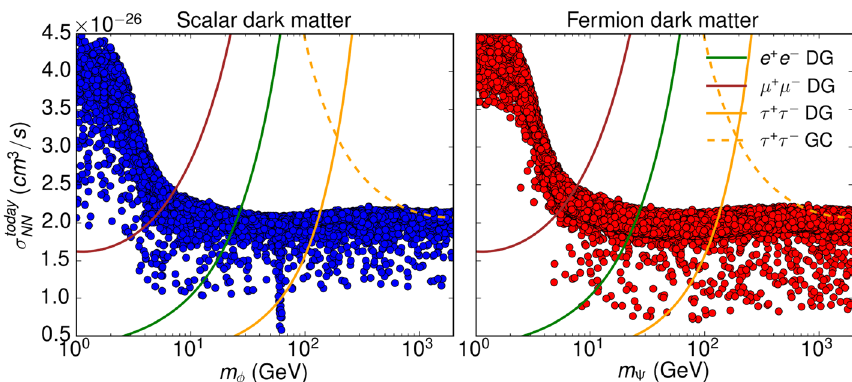
Fig. 7 Annihilation cross section today and lines of exclusion of decays to leptons from Fermi-LAT from dwarf galaxies and H.E.S.S. from the galactic center, for the cases of scalar ( left ) and fermionic ( right ) Dark